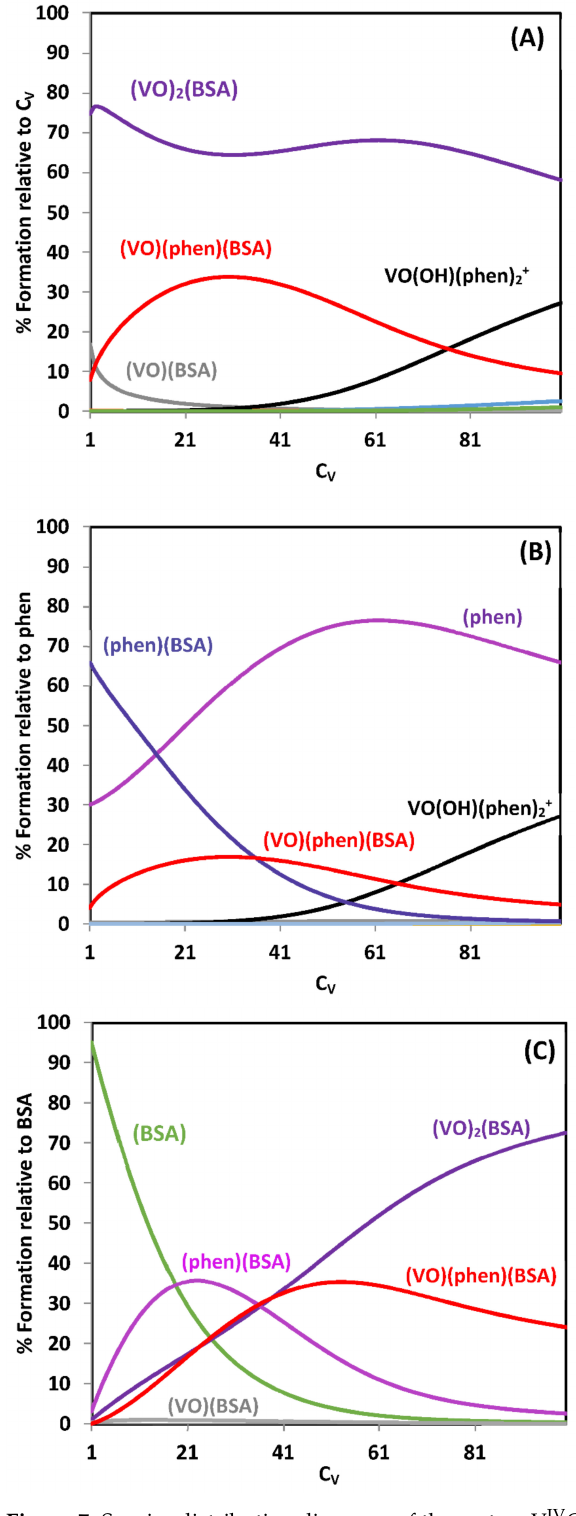
Figure 7. Species distribution diagrams of the system V IV O 2+ +phen+BSA at pH = 7 (range of C V val- ues: 1 to 100 µ M) calculated using the HySS program [33], taking a molar ratio V IV O:phen of 1:2 and [BSA] = 40 µ M. The binding of phen to BSA is taken into account with a binding constant of 5.7 × 10 4 , and the formation of V IV O-phen-BSA species with a stability constant of 10 15 (which corresponds to K 1 BC ~10 9 , see also text). ( A ) Representation of vanadium containing species; ( B ) Representation of 1,10-phenanthroline containing species; ( C ) Representation of BSA containing